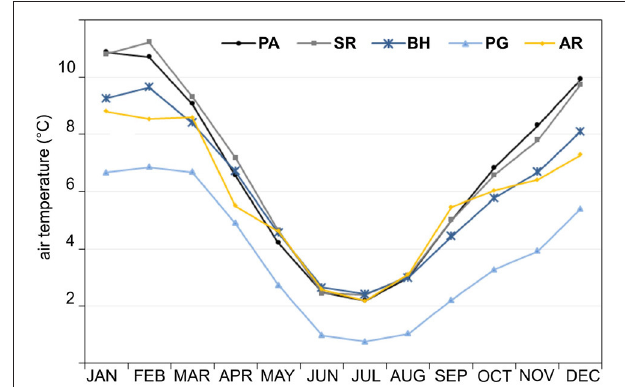
FIGURE 3 | Mean monthly air temperature at AWS Arévalo (AR), AWS Paso Galería (PG), AWS Puerto Bahamondes (BH), AWS Skyring (SR), and WS Punta Arenas (PA) averaged over the individual observation period ( Figure 2